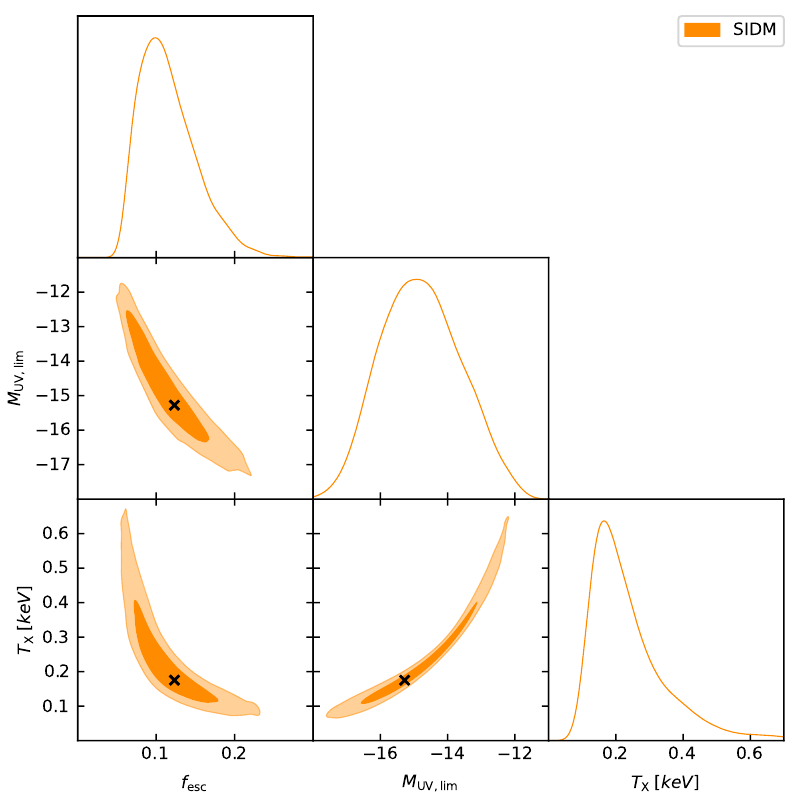
Figure 8. MCMC posterior distributions in the SIDM scenario (orange contours/lines), for the escape fraction f esc of ionizing photons, the limiting UV magnitude M UV,lim , and visible sector temperature T X at kinetic decoupling. The contours show 68% and 95% confidence intervals, the black cross shows the maximum likelihood position, and the marginalized distributions are in arbitrary units (normalized to 1 at their maximum